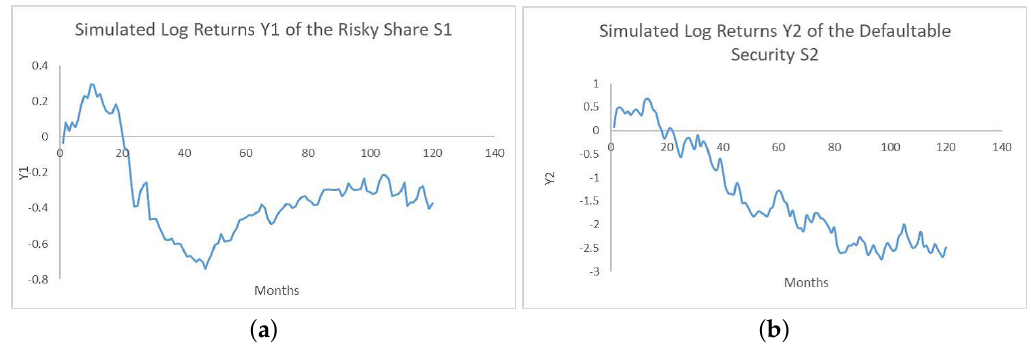
Figure 1. Simulated log returns Y 1 and Y 2 for the risky share and the defaultable security. Panel ( a ) for the ordinary share and Panel ( b ) for the defaultable